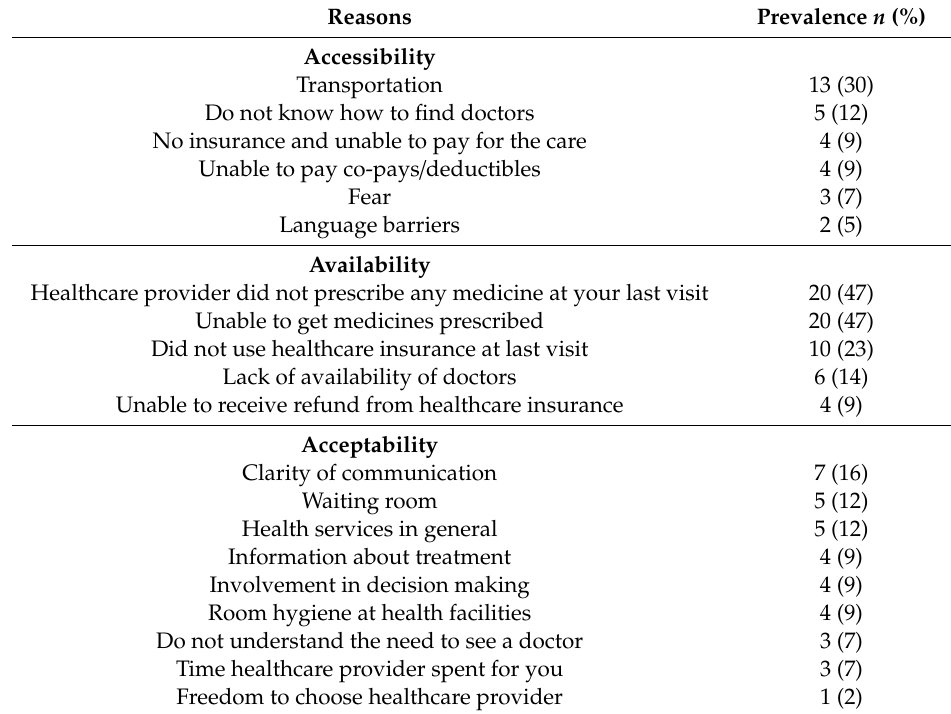
Table 3. Reasons for not using health services in the unmet healthcare needs group.